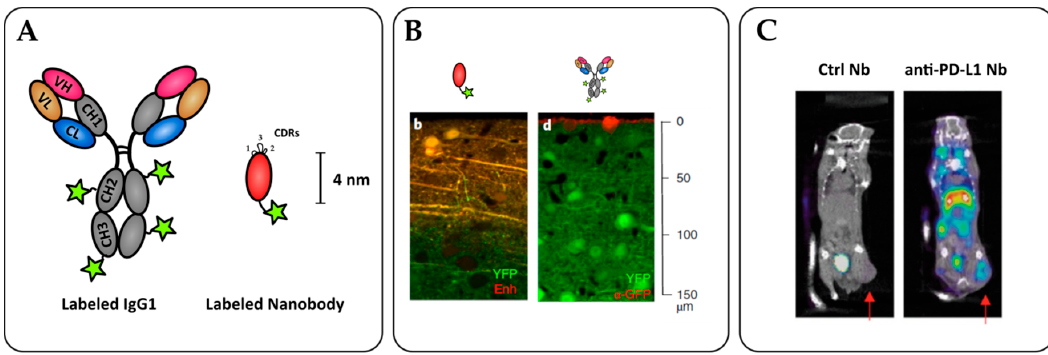
Figure 3. Nanobodies as potent tools for tumor immunoimaging. ( A ) Nanobody labelling